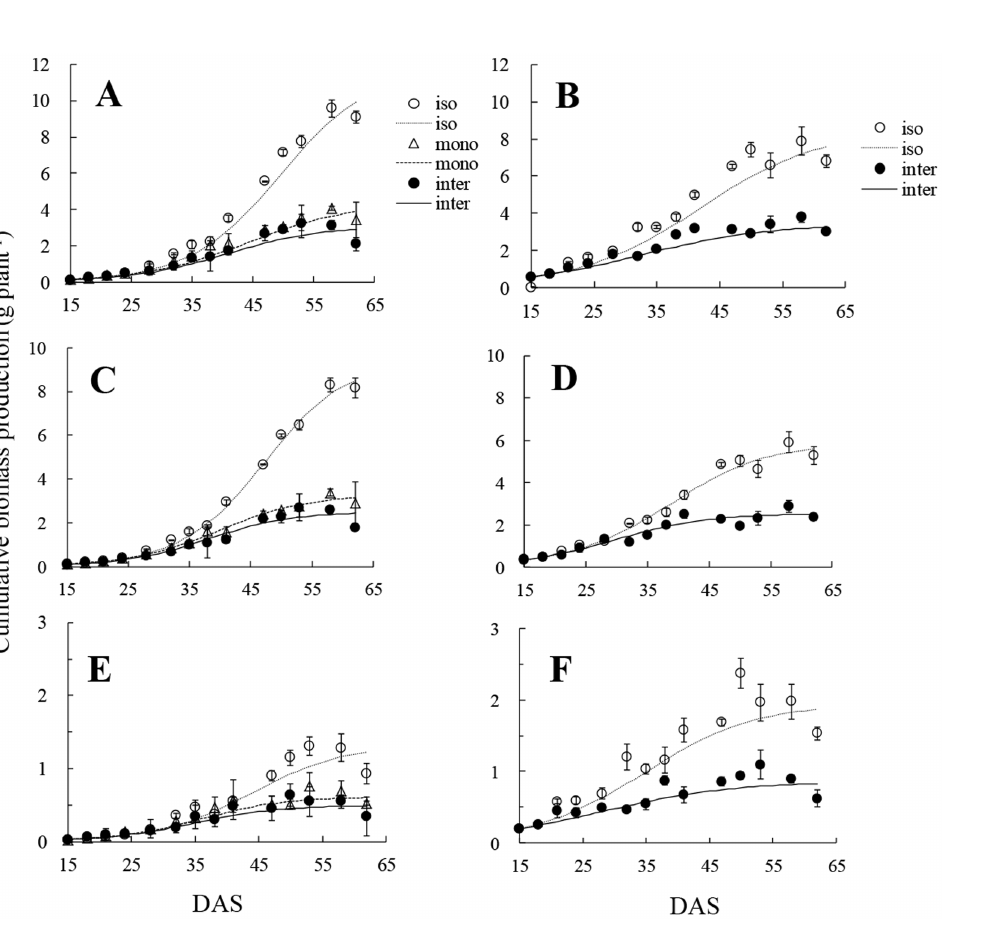
Fig. 2. Cumulative biomass production. A, B: total plant biomass of wheat, and faba bean; C, D: shoot biomass of wheat, and faba bean; E, F: root biomass of wheat, and faba bean. iso: isolated plants; mono: monocropped plants; inter: intercropped plants. Open and solid circles, open triangles indicate the mean of actual data at each sampling. All values represent means ¡ SE (n 5 3). Curves are derived from the logistic equation using the mean of three